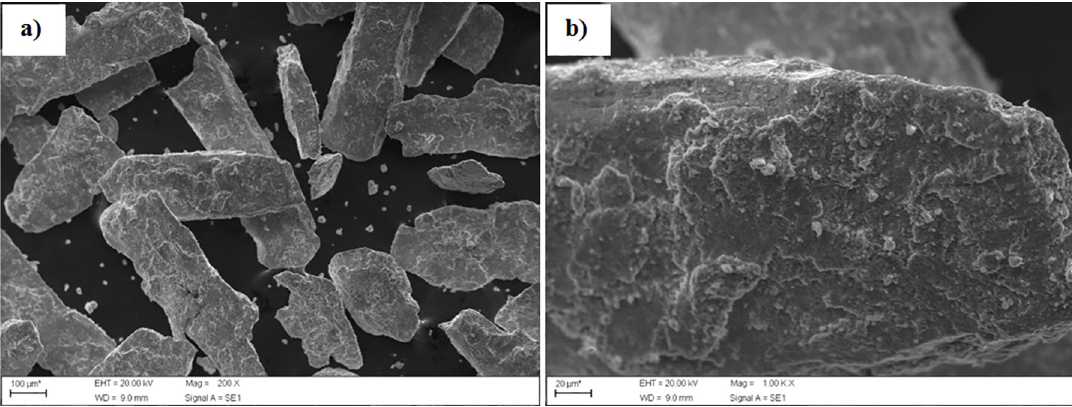
Figure 3. Aluminum bronze milled for 30 hours in rod shaped (a); lump of one particle (b).